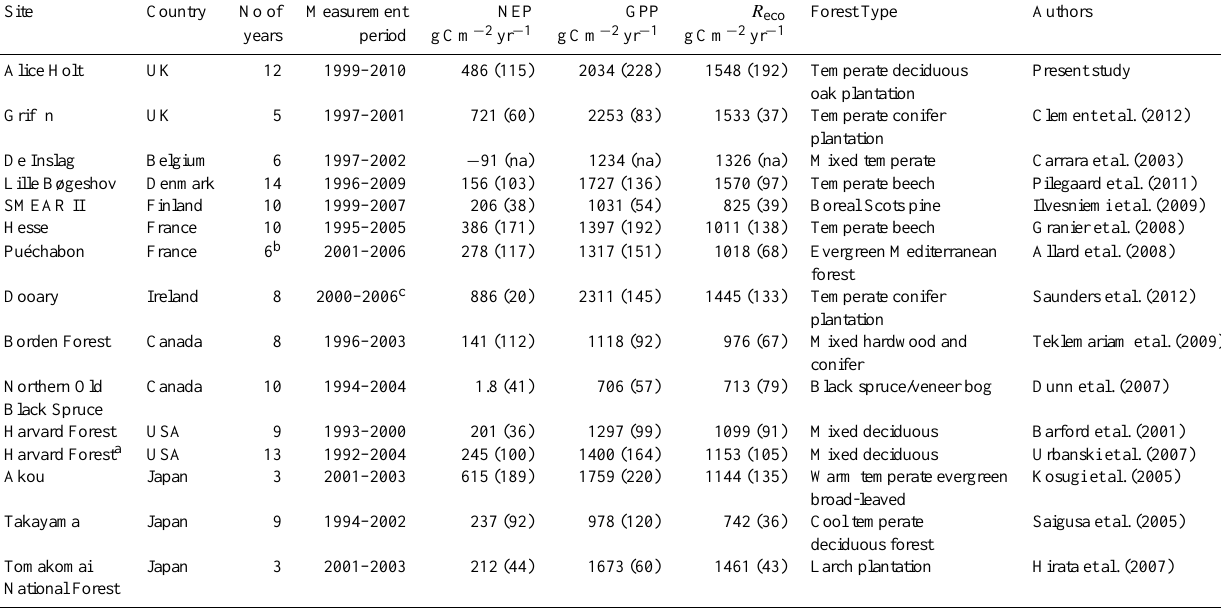
Table 6. Published multi-annual values of NEP, GPP and R eco for a range of temperate and boreal forest ecosystems